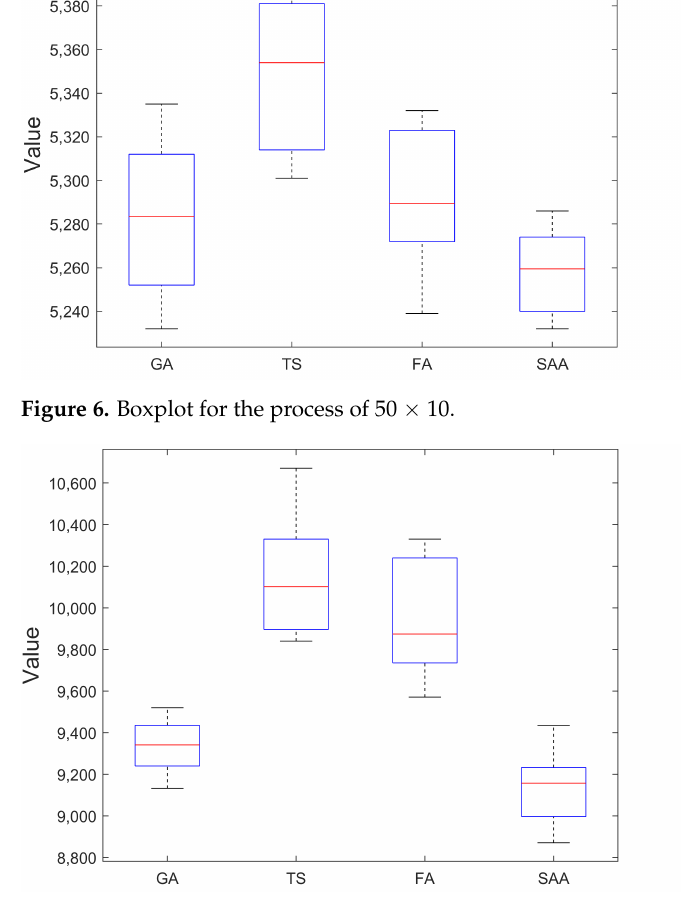
Figure 7. Boxplot for the process of 100 × 10.